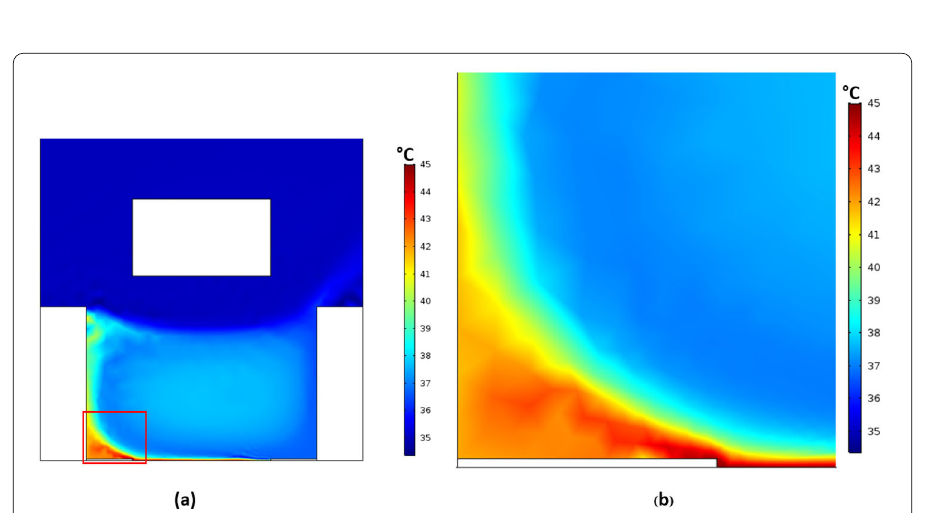
Figure 4 The surface temperature ( ° C) at steady state when u = 7 km/h (gentle wind): ( a ) Half of the entire computational domain, and ( b ) Zoom-in of the selected area